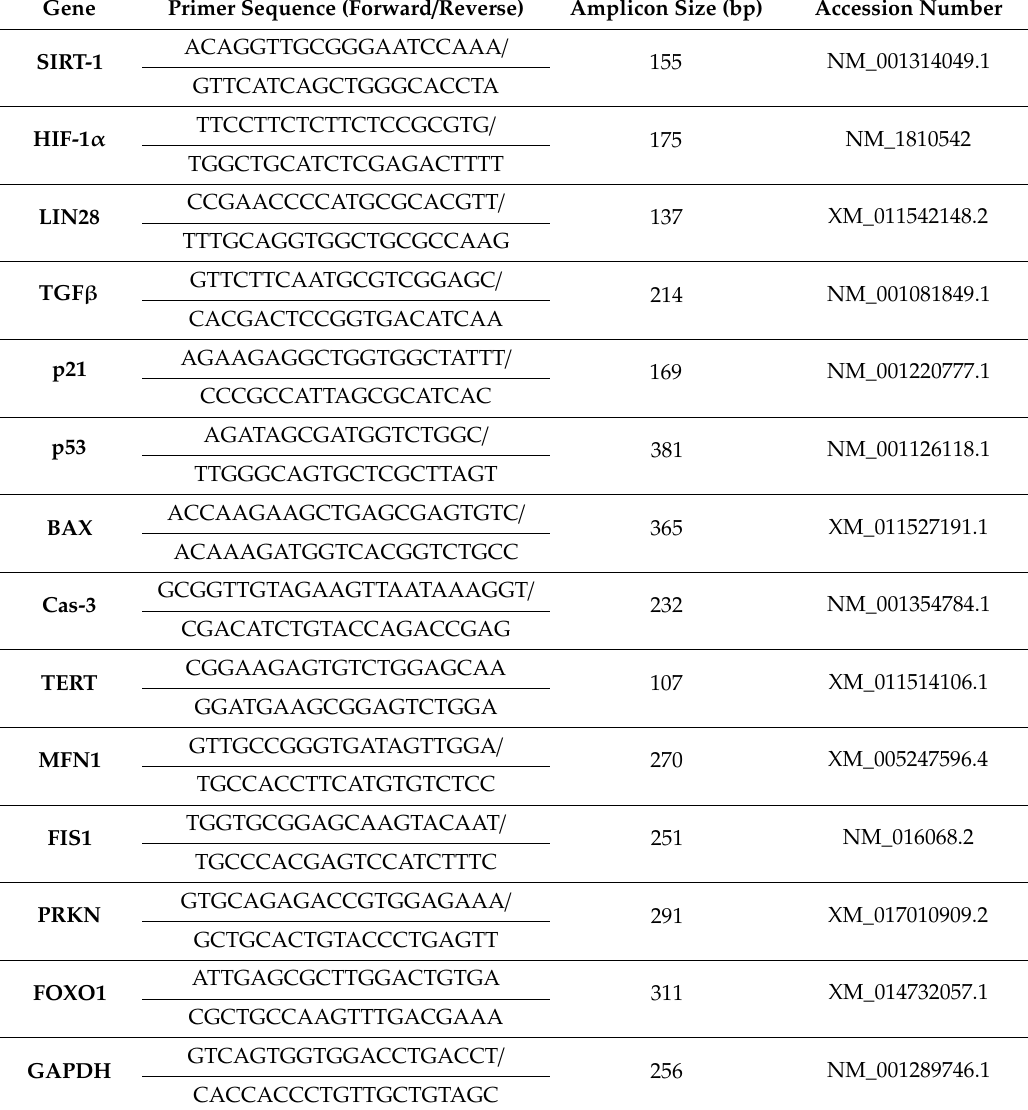
Table 1. List of genes with accession numbers, sequences of primers, and the amplicon size of the products in quantitative